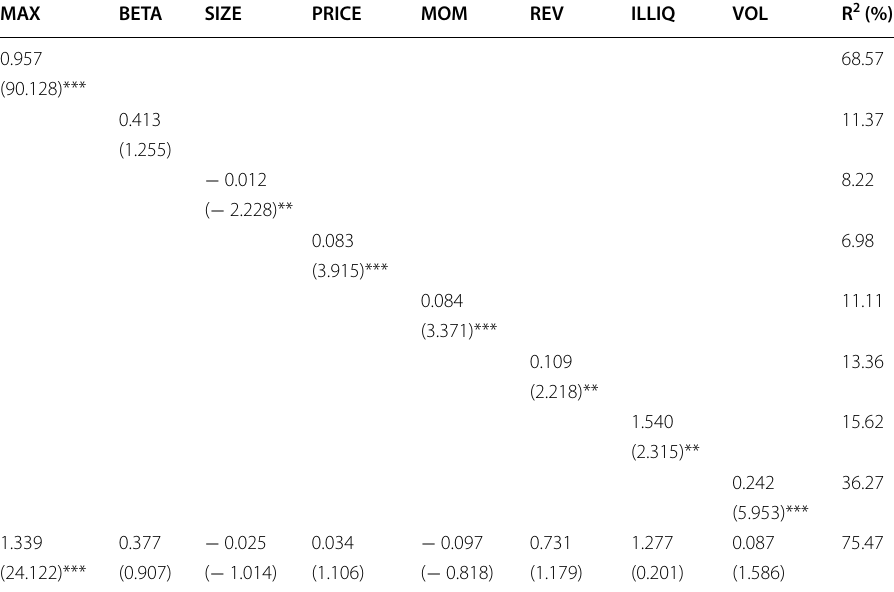
Table 4 Cross-sectional predictability of